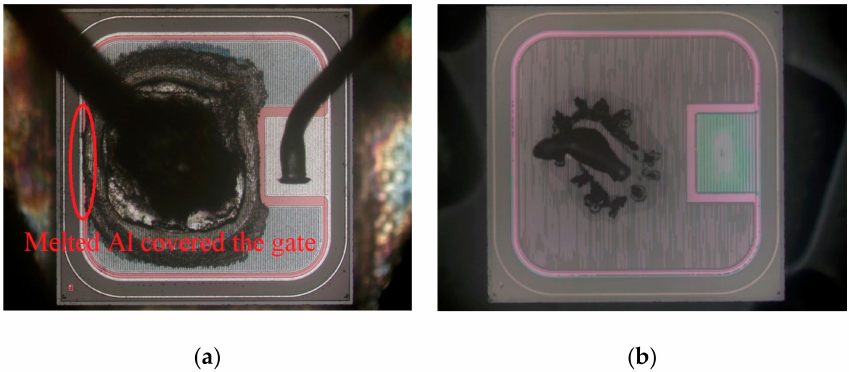
Figure 10. The anatomy results of STM device SCT10N120 ( a ) decapping, ( b ) removing layers to the substrate layer.